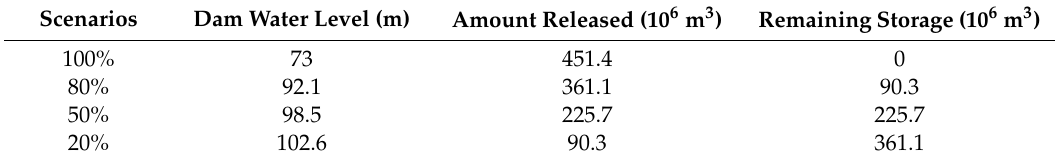
Table 4. Threshold water level corresponding to 4 dam failure scenarios.